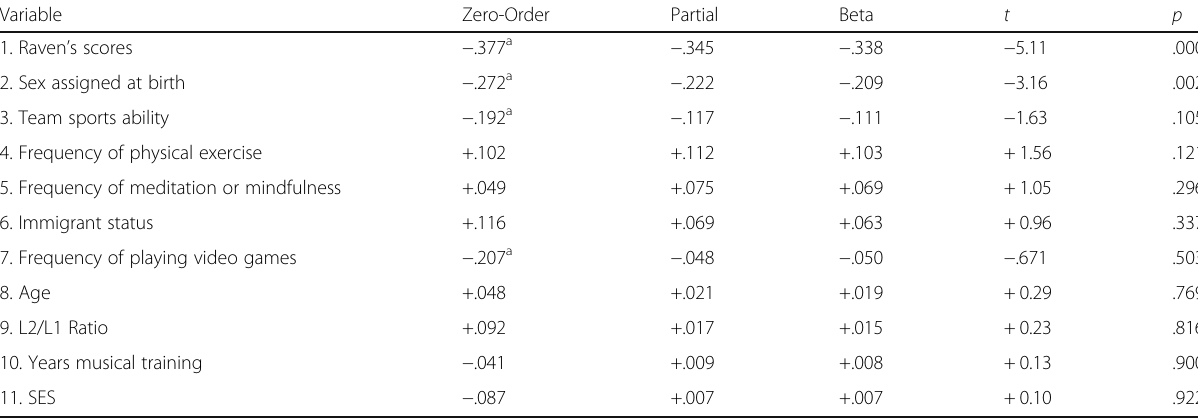
Table 4 Correlations and standardized regression coefficients (Beta) for 11 predictors of a composite interference score based on the standardized RT interference scores for the Simon, spatial Stroop, and vertical Stroop tasks